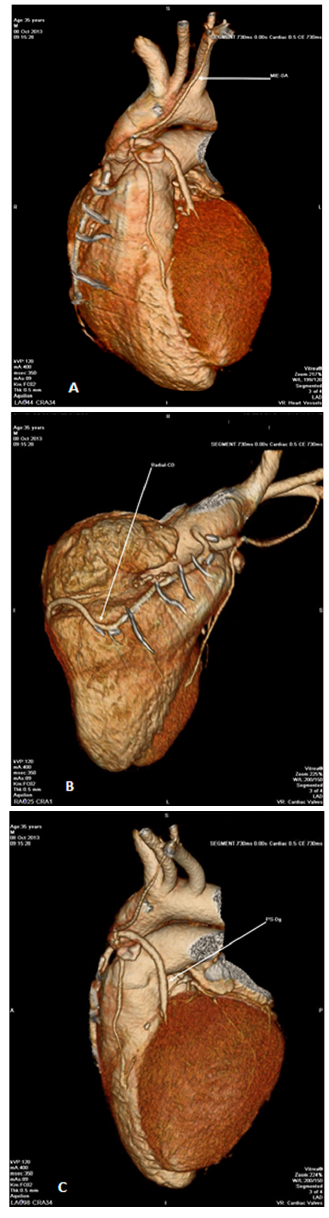
Fig. 1 - Coronary CT